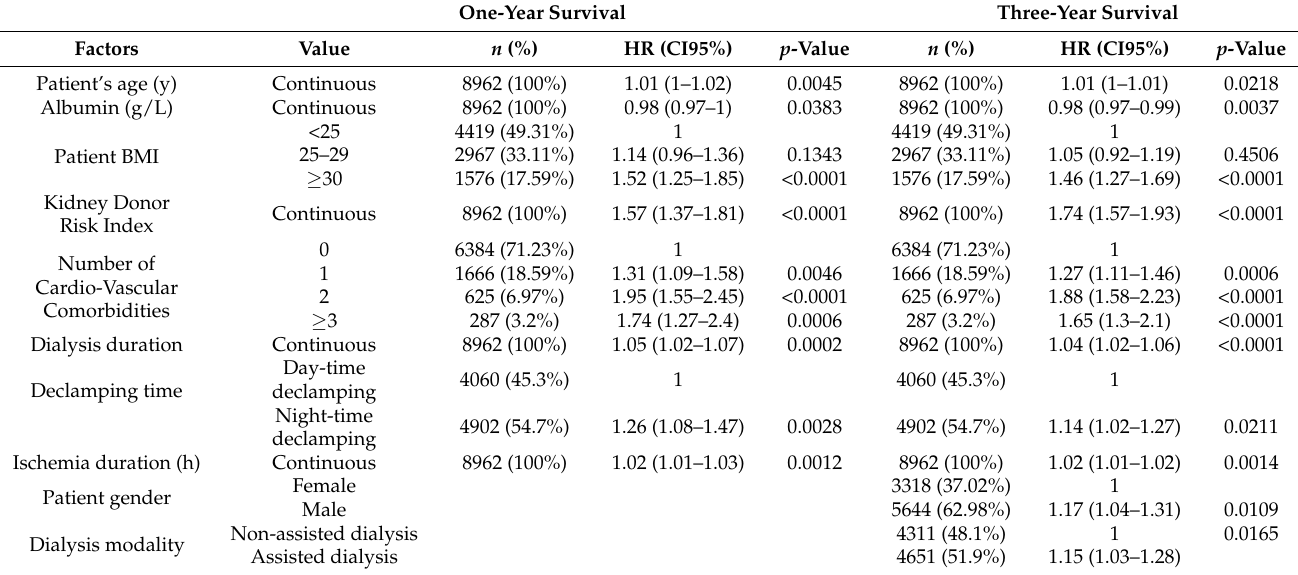
Table 2. Factors associated with 1 and 3-year survival (i.e., patient or non-death censored graft survival) according to the multivariate Cox